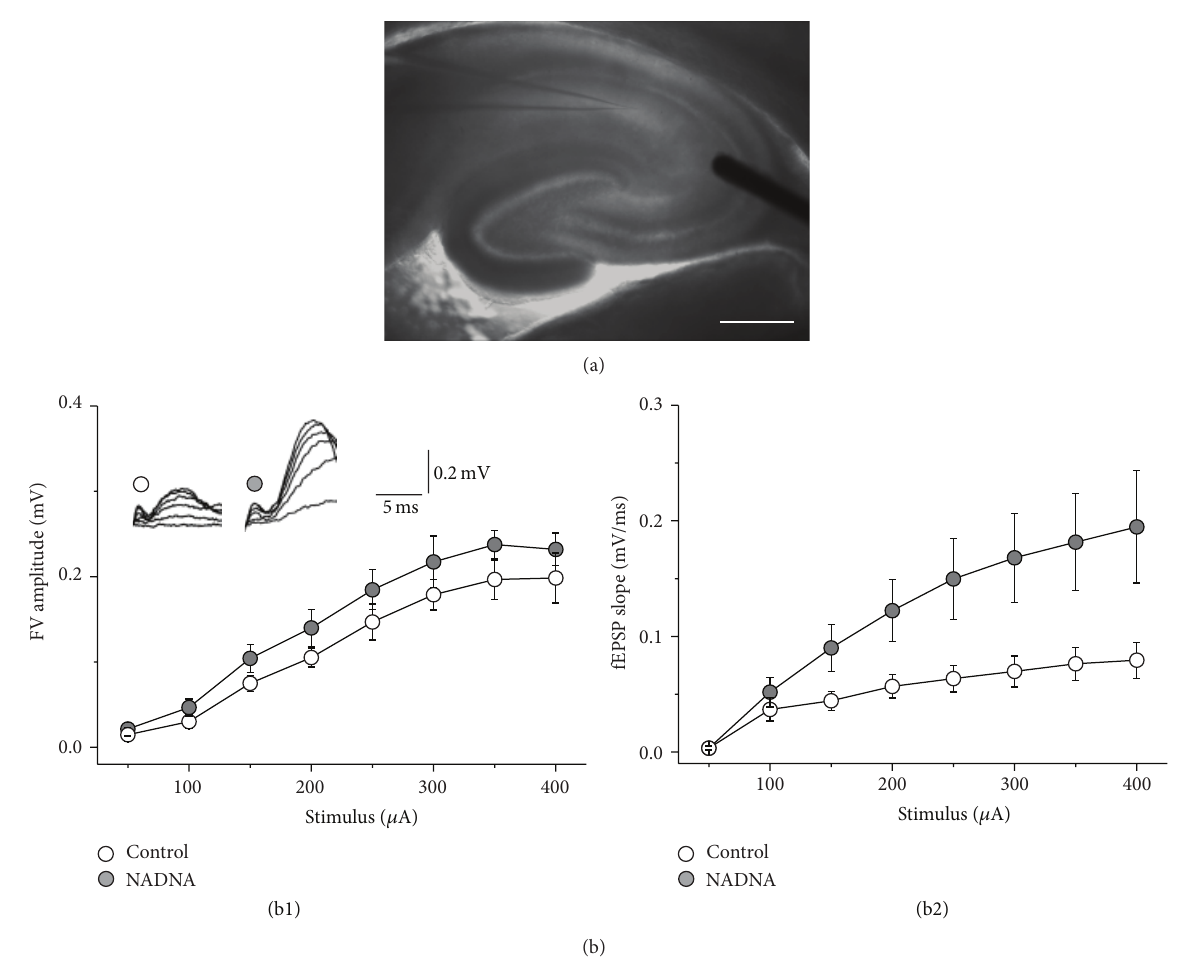
Figure 1: Inhibition of NEU activity affects basal evoked excitatory synaptic transmission. (a) The arrangement of electrodes for recordings. fEPSPs were evoked by stimulation of Shaffer collaterals using concentric electrode (right) and recorded using a glass electrode (left) filled with extracellular solution placed in CA1 SR region. Scale bar, 0.5 mm. (b) Input-output curves show significant increase of the maximal fEPSP slope after suppression of NEU activity without the effect on the fiber volley (FV)